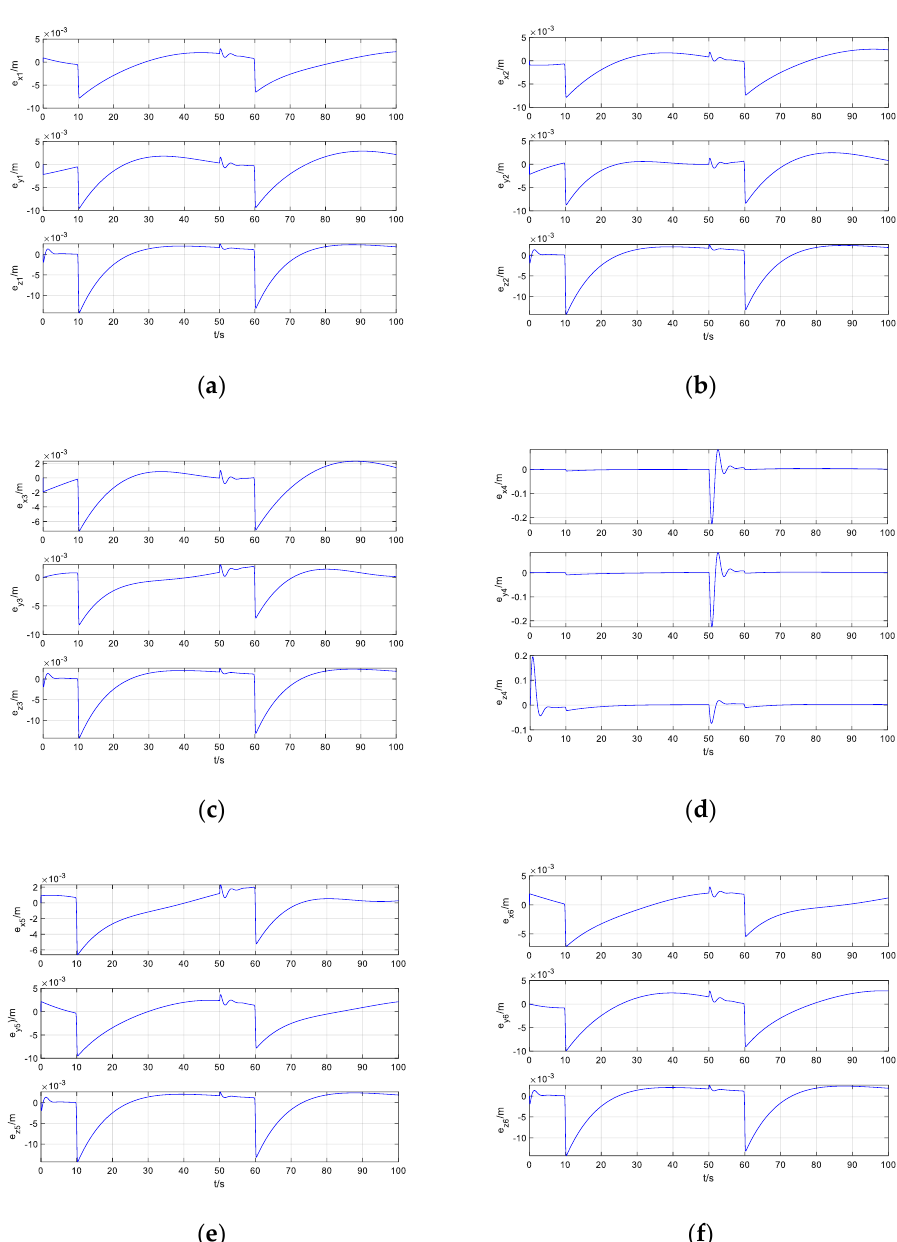
Figure 8. Follower1-Follower6 tracking error when increase the disturbance: ( a ) Follower1; ( b ) Follower2; ( c ) Follower3 ; ( d ) Follower4; ( e ) Follower5; ( f ) Follower6. ( b ) Follower2; ( c ) Follower3; ( d ) Follower4; ( e ) Follower5; ( f )